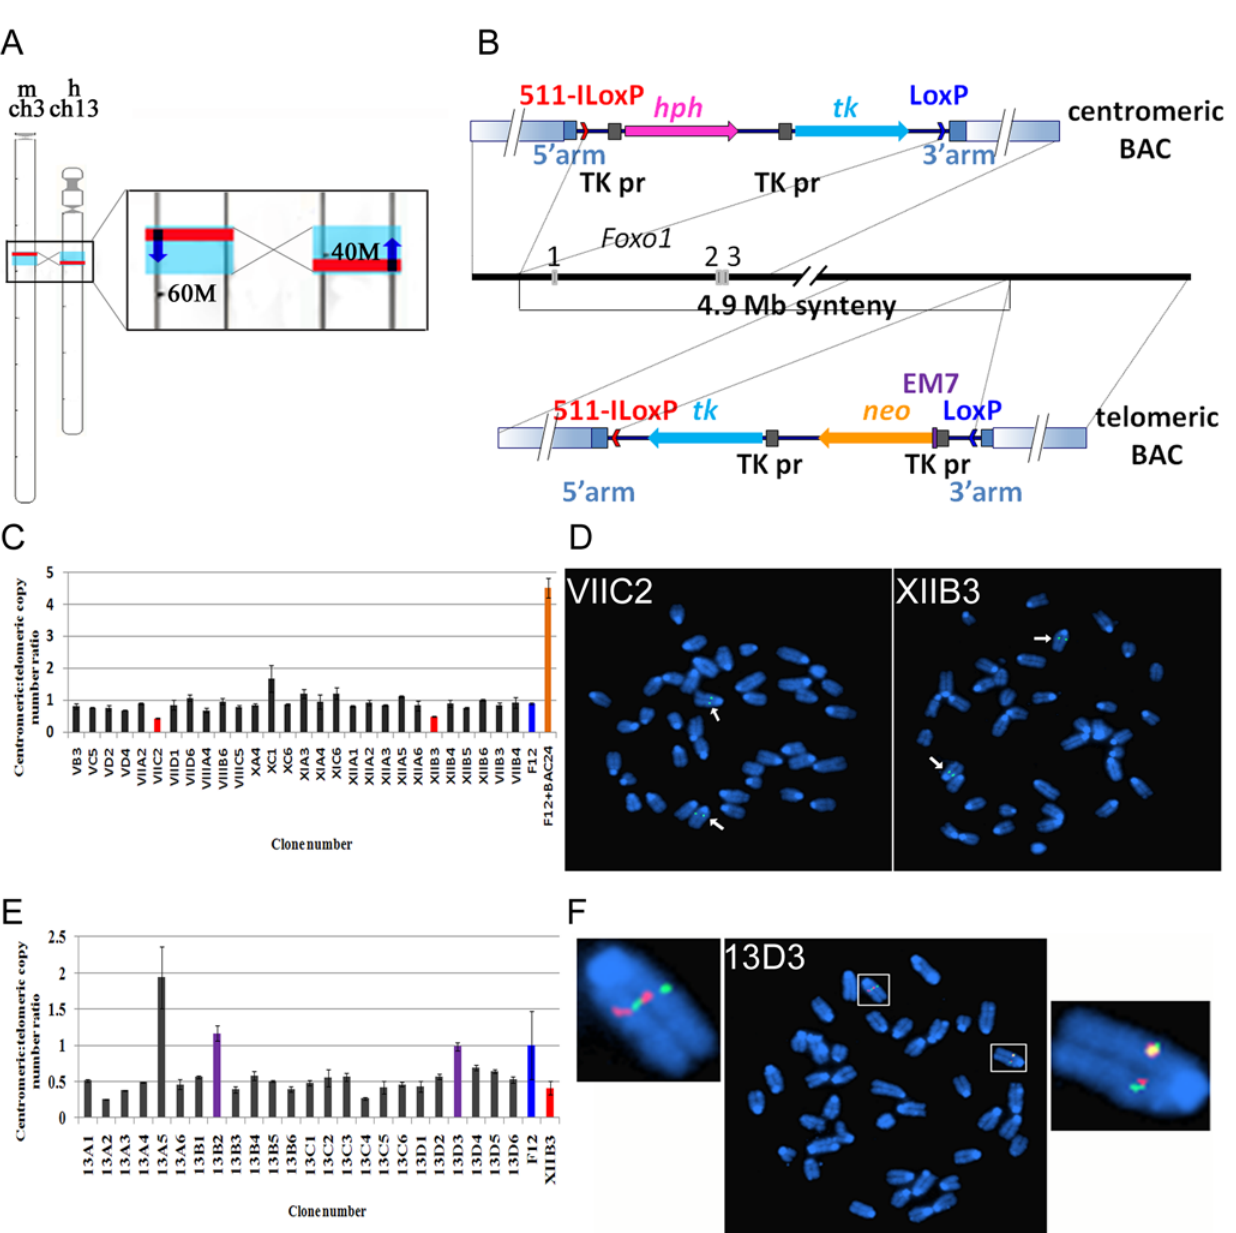
Figure 2. Strategy to invert a 4.9Mb region on mouse chromosome 3-containing Foxo1 . A. Left, schematic representation of mouse chromosome 3 and human chromosome 13. Red lines indicate the relative positions of the Foxo1 and FOXO1 genes, blue boxes represent the syntenic regions. Right, enlargement of the chromosome areas boxed on the left showing the position of Foxo1 and FOXO1 (red rectangles), the position of the respective 4.9Mb syntenic regions (blue rectangles) and the transcriptional direction of the Foxo1 and FOXO1 genes (dark blue arrows). Numbers (60M, 40M) indicate the distance in Mb from the centromere. B. Scheme of two consecutive rounds of targeting in mouse ES cells of the centromeric (top) and telomeric (bottom) borders of the 4.9 Mb syntenic region. 511-ILoxP (red arrowhead) and LoxP (blue arrowhead) — two incompatible loxP sites, with arrowheads indicating their relative orientation; hph — Hygromycin-B resistance gene; neo — Neomycin resistance gene; tk — HSV1-thymidine kinase gene; TK pr — HSV1-thymidine kinase promoter; EM7 — prokaryotic promoter; solid blue rectangles indicate homology arms used for recombineering in BACs; gradient blue rectangles